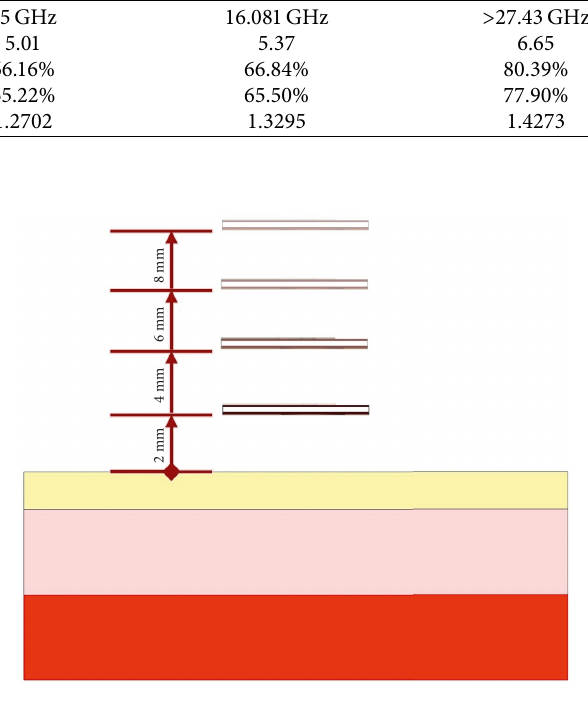
Figure 33: Different distances for on-body